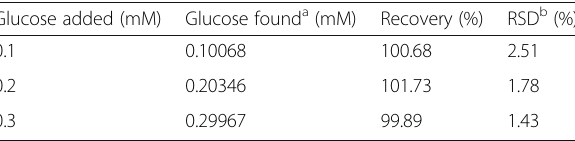
Table 2 Real sample analysis of glucose in human serum